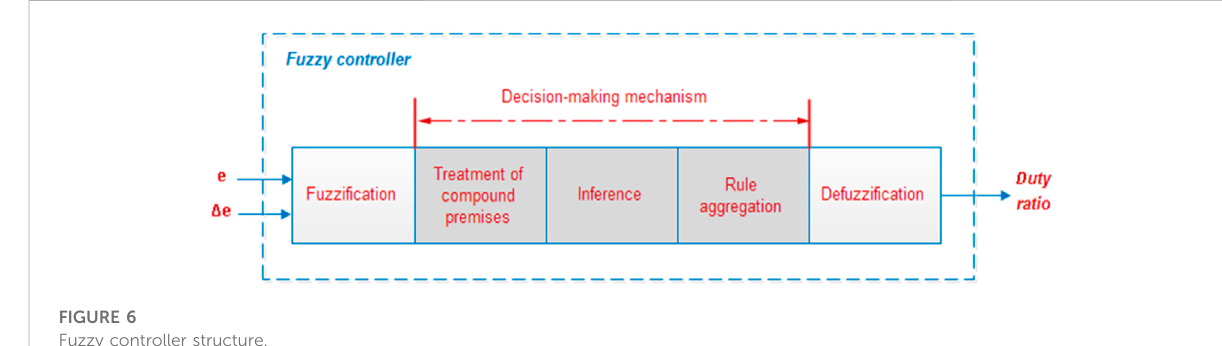
FIGURE 6 Fuzzy controller structure.